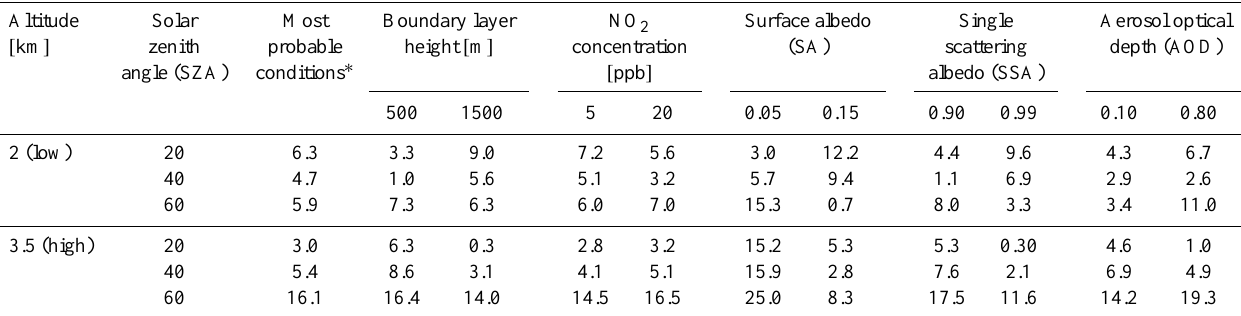
Table 4. Relative error of geometric approximation compared to AMF calculated for nadir viewing geometry at 455nm using radiative transfer program McArtim under different scenarios.